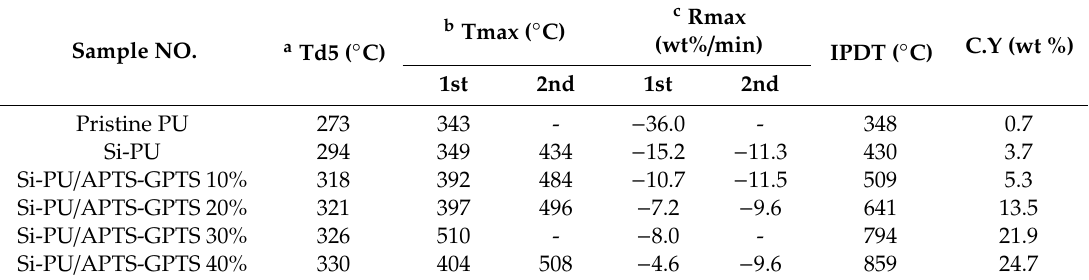
Table 2. Thermal properties of pristine PU and Si-PU / APTS-GPTS